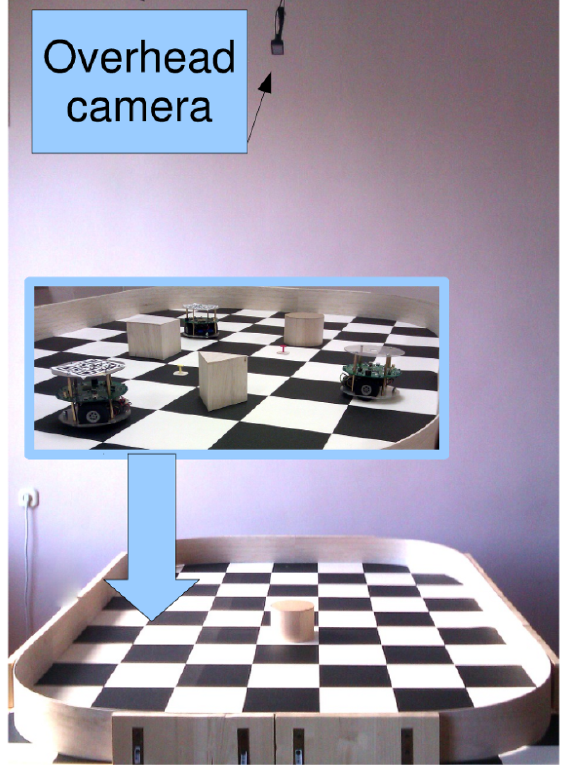
Figure 13: Testing area